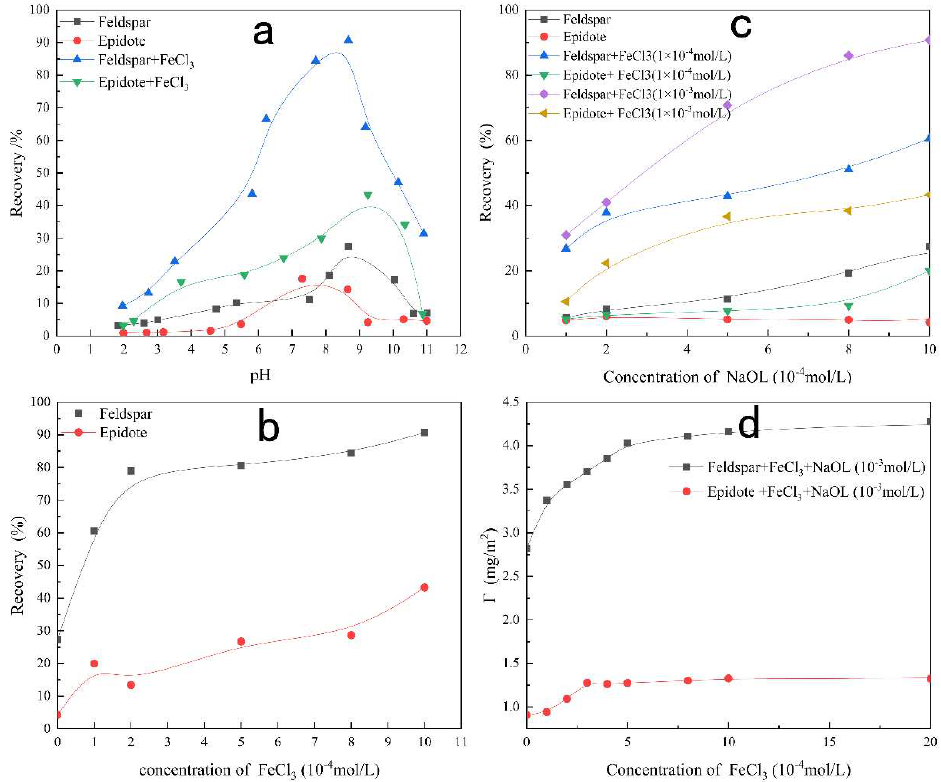
Figure 4. Flotation recovery of minerals as a function of pH. ( a ) NaOL concentration under natural pH ( b ); Fe 3+ concentration under natural pH ( c ); the adsorption as a function of NaOL ( d ).